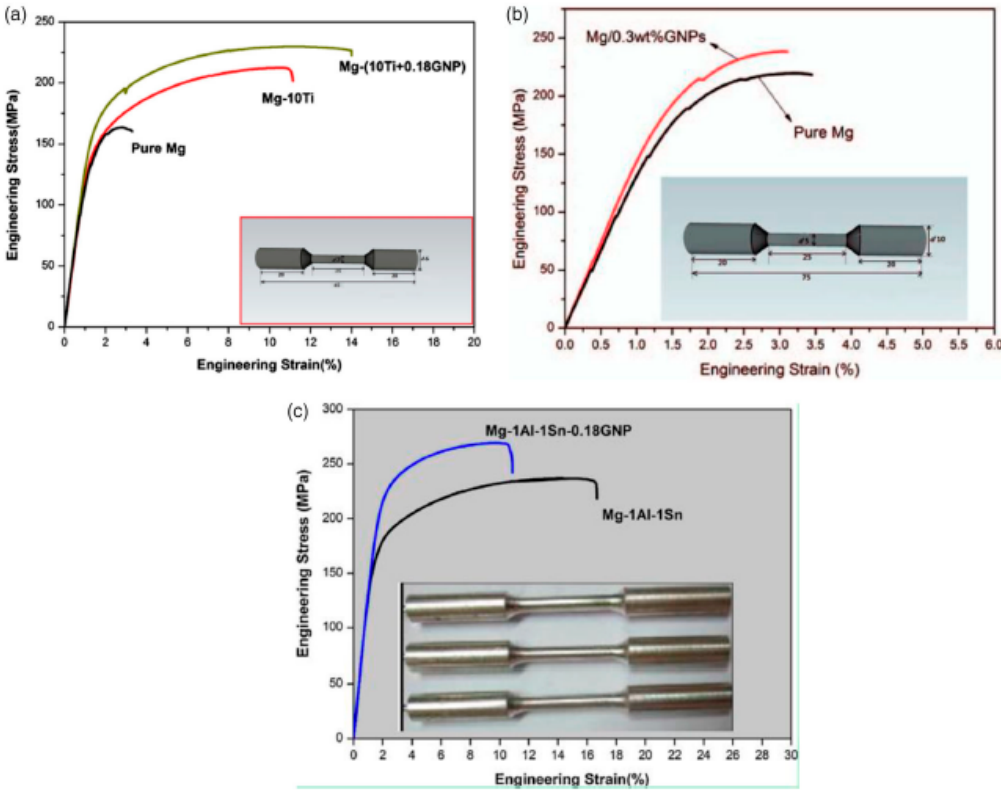
Figure 12. ( a ) Tensile test of pure Mg, Mg–10Ti alloy and Mg–(10Ti + 0.18 wt.% GNPs) nanocomposites at room temperature, ( b ) tensile test of pure Mg and 0.3 wt.% GNPs-Mg nanocomposite, and ( c ) tensile test of 0.18 wt.% GNPs-Mg–1%Al–1%Sn nanocomposite and Mg–1%Al–1%Sn alloy [32] (Copyright, 2016, Materials Science and Technology).